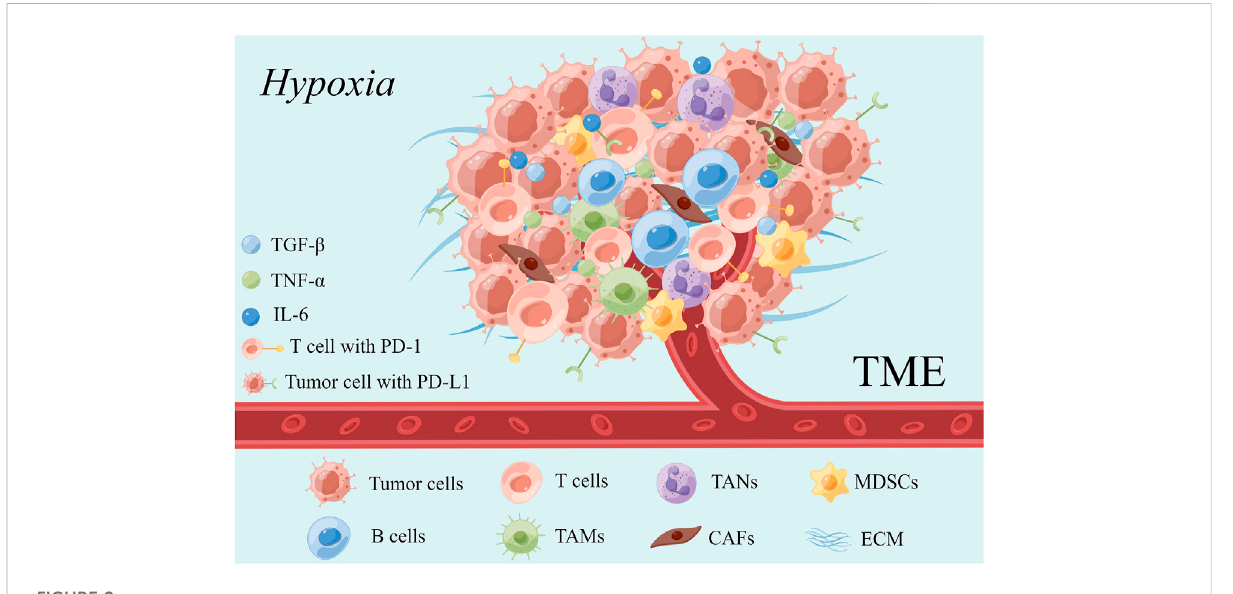
FIGURE 2 Constituents of the TME (edited by Figdraw